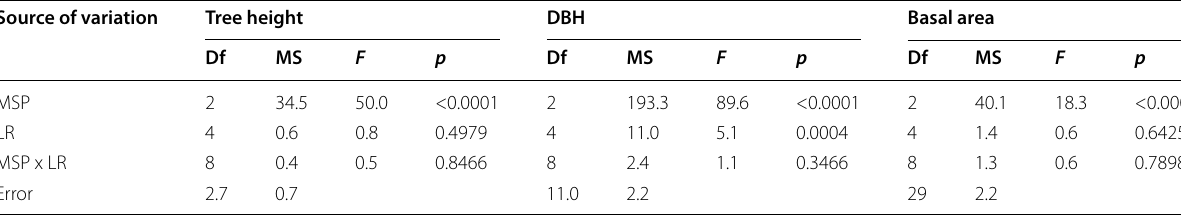
Table 4 Results of two‑way ANOVA, presenting the effects of mechanical site preparation (MSP), logging residue treatment (LR), and their interactions on tree height, DBH, and basal area of sampled Scots pines 12 years after planting Source of variation Tree height